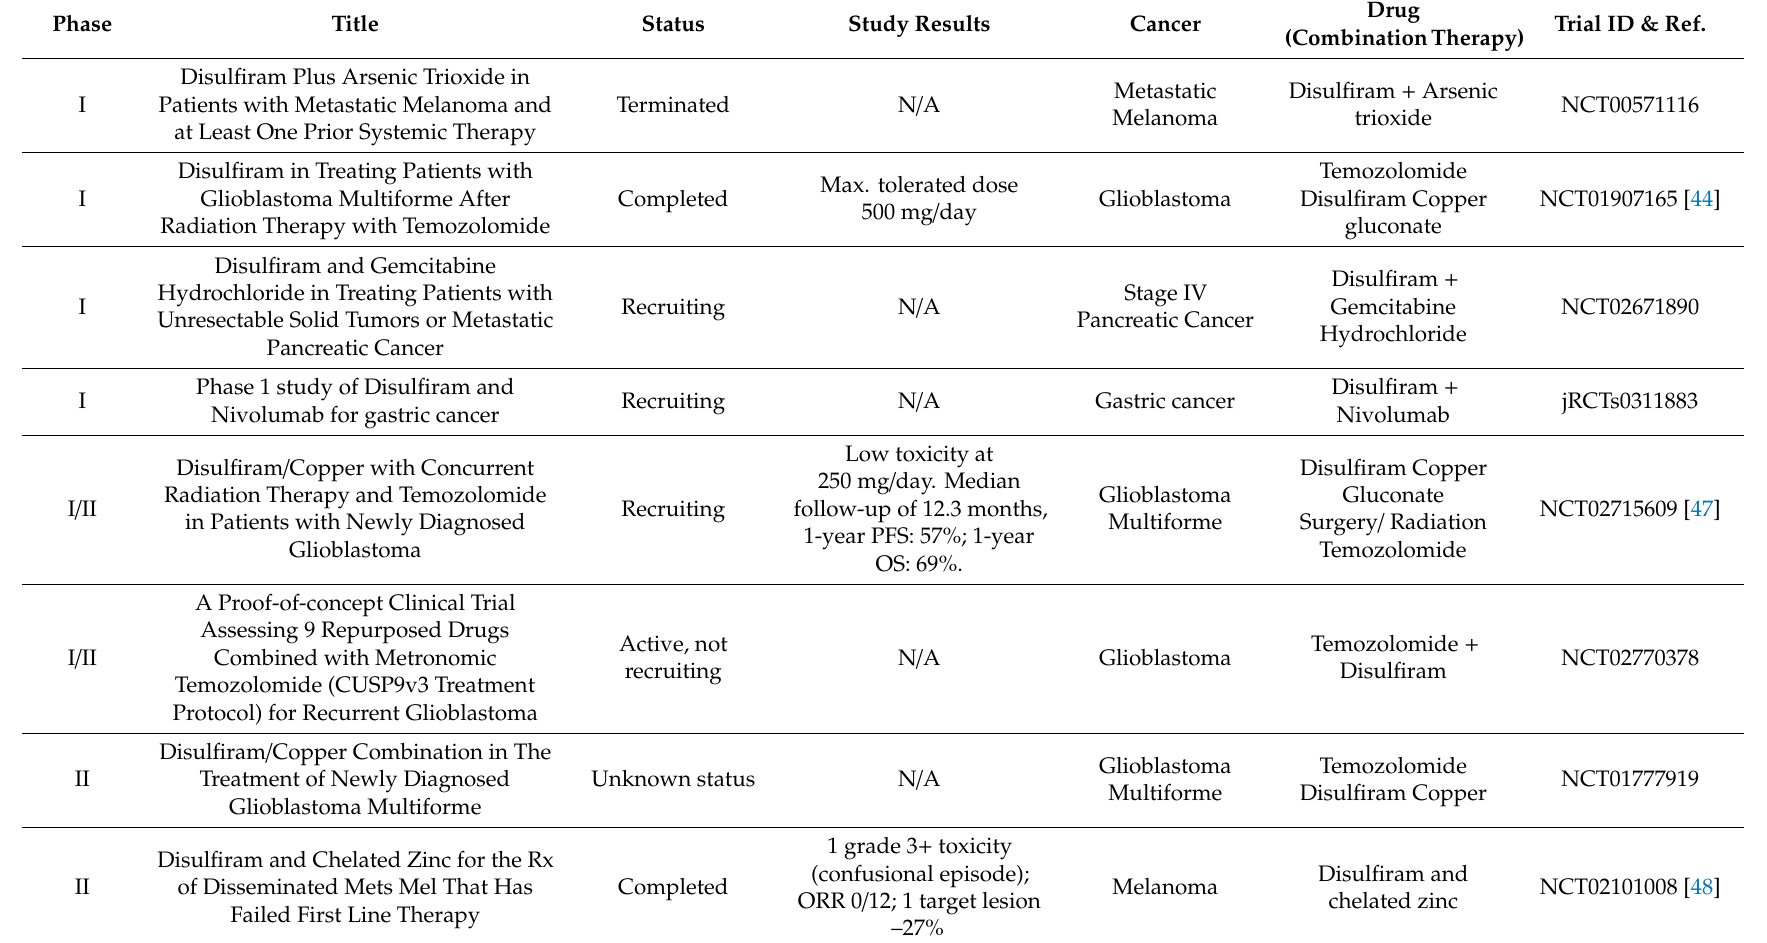
Table 2. Clinical trials using disulfiram as combination therapy in cancer